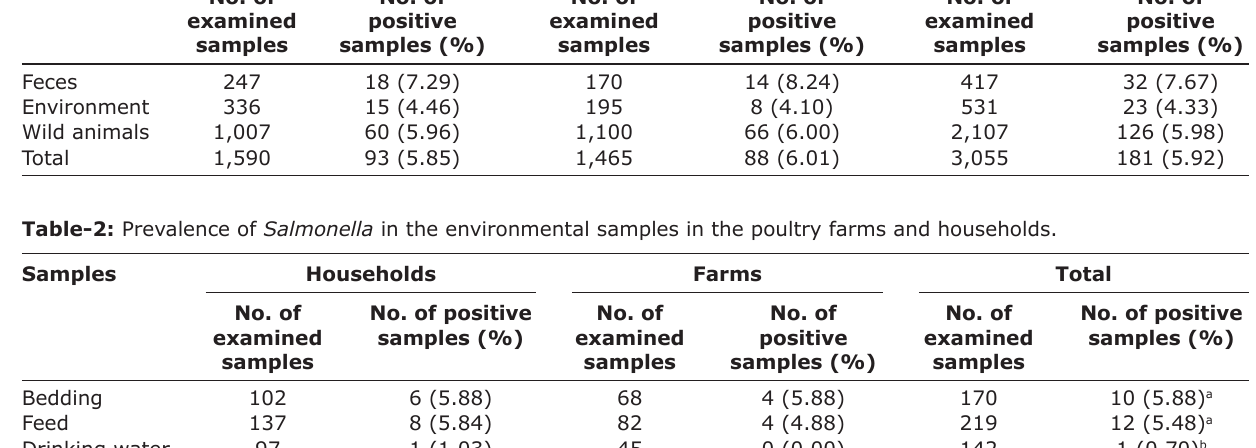
Table-1: Prevalence of Salmonella in the poultry farms and households in the Mekong Delta, Vietnam.